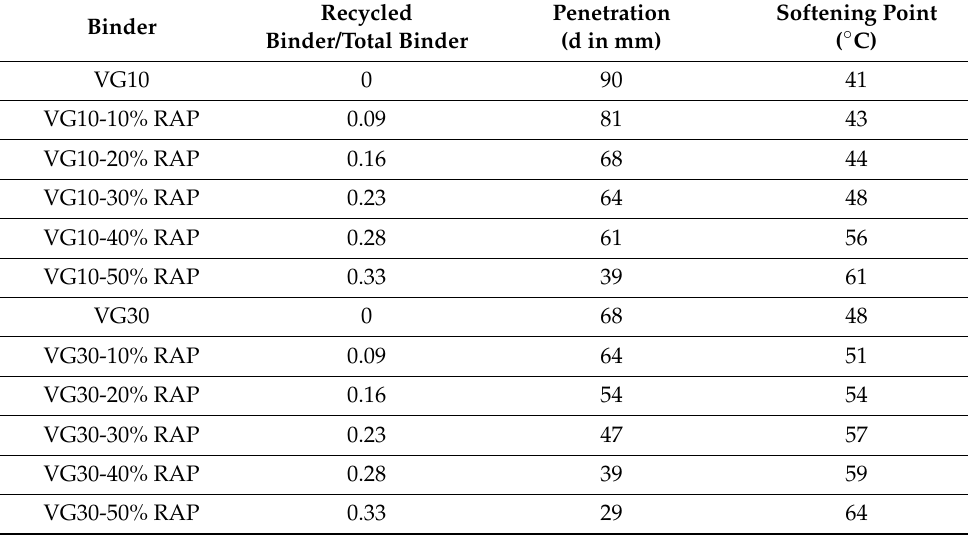
Table 5. Physical Properties of